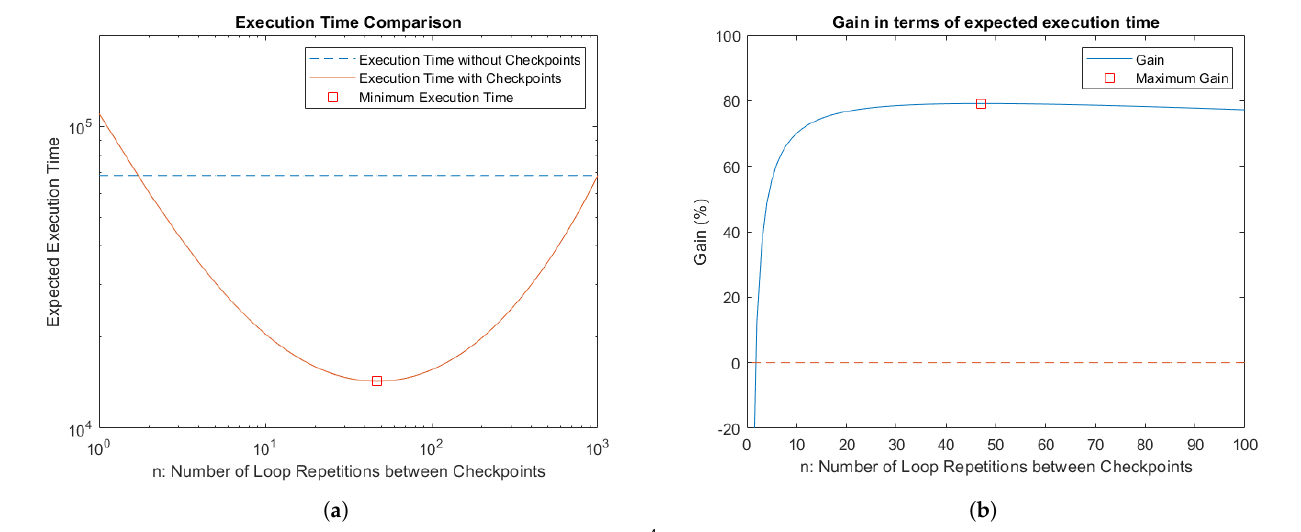
Figure 1. The case of a small software program (i.e., Y = 10 4 ): ( a ) Expected execution time comparison (logarithmic axes) ( b ) Expected execution time